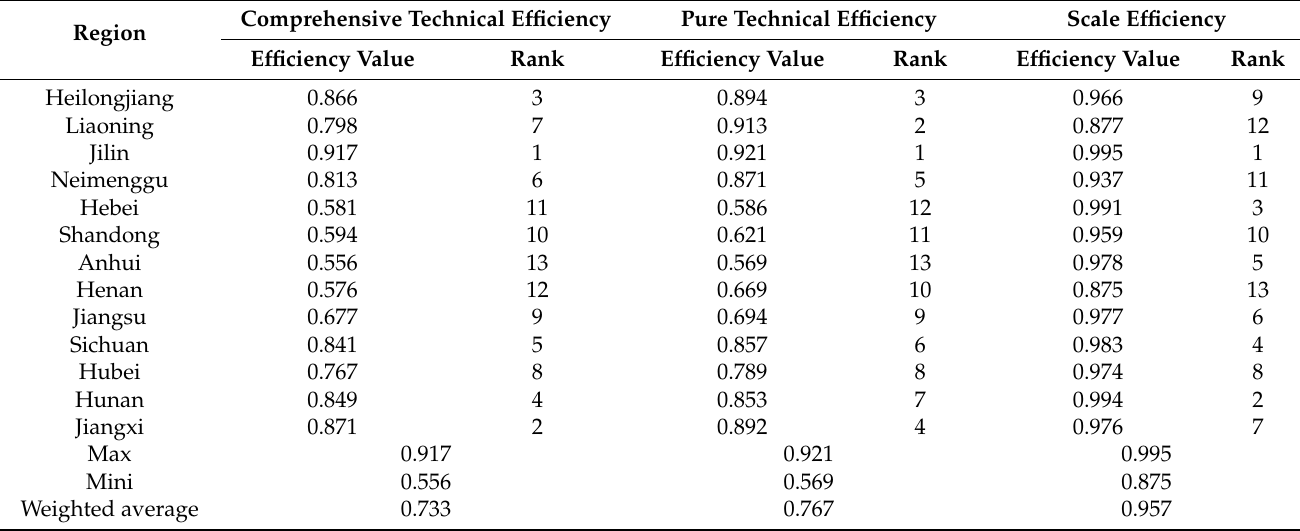
Note: The three efficiency values of each region in the table are the average values from 2000 to 2019. The overall efficiency is a weighted average of the total output of each region in the major producing areas. Table 1 shows the measurement results of the traditional envelope analysis